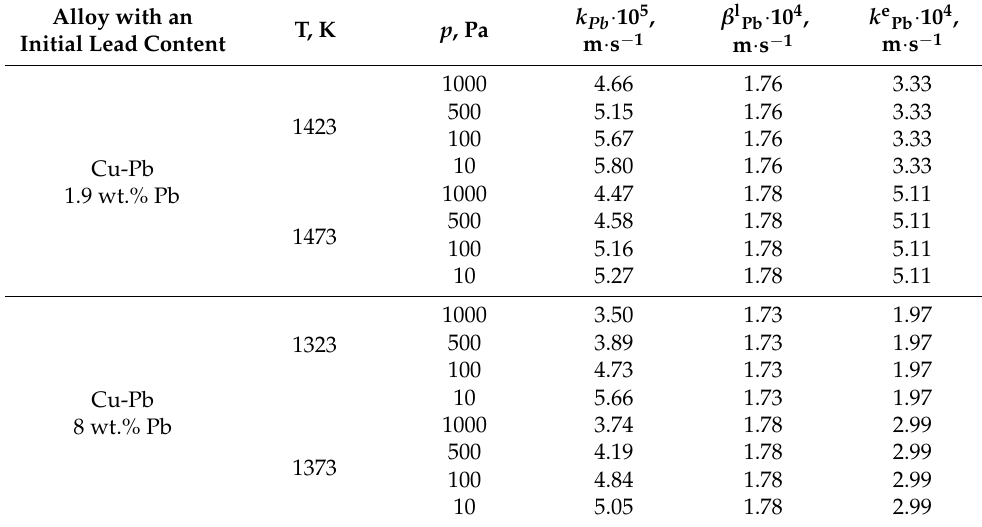
Table 6. The overall mass transfer coefficient k Pb and coefficient β l Pb and k e Pb (ICF). Alloy with an